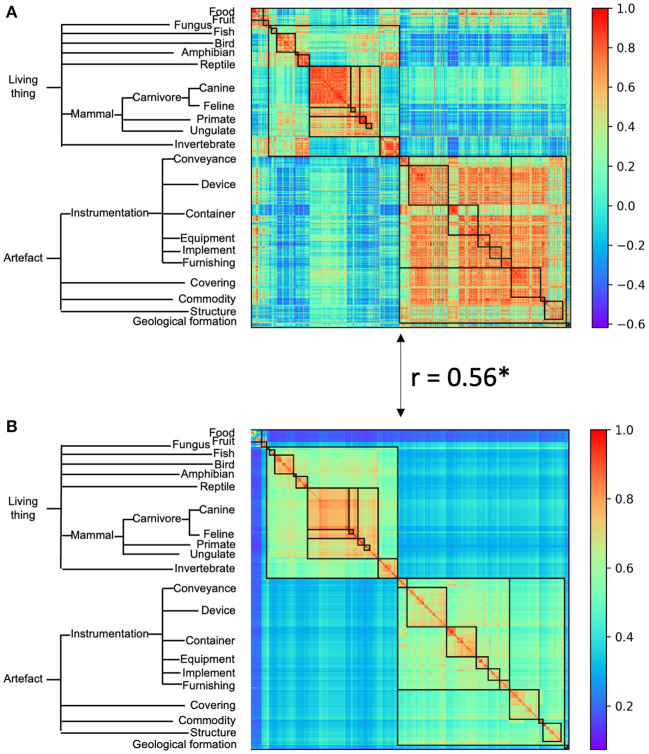
The category representational similarity of the AlexNet (A) and the semantic similarity of WordNet hierarchy (B). Categories were ordered according to the WordNet semantic hierarchy. A simplified hierarchical structure was shown as an indicator of superordinate categories in WordNet semantic similarity. For the ease of comparison between AlexNet's category similarity and WordNet semantic similarity, categories belong to the same superordinate category were marked with a black box. The AlexNet category similarity showed good correspondence to the WordNet semantic similarity. Asterisk denotes p < 0.001.